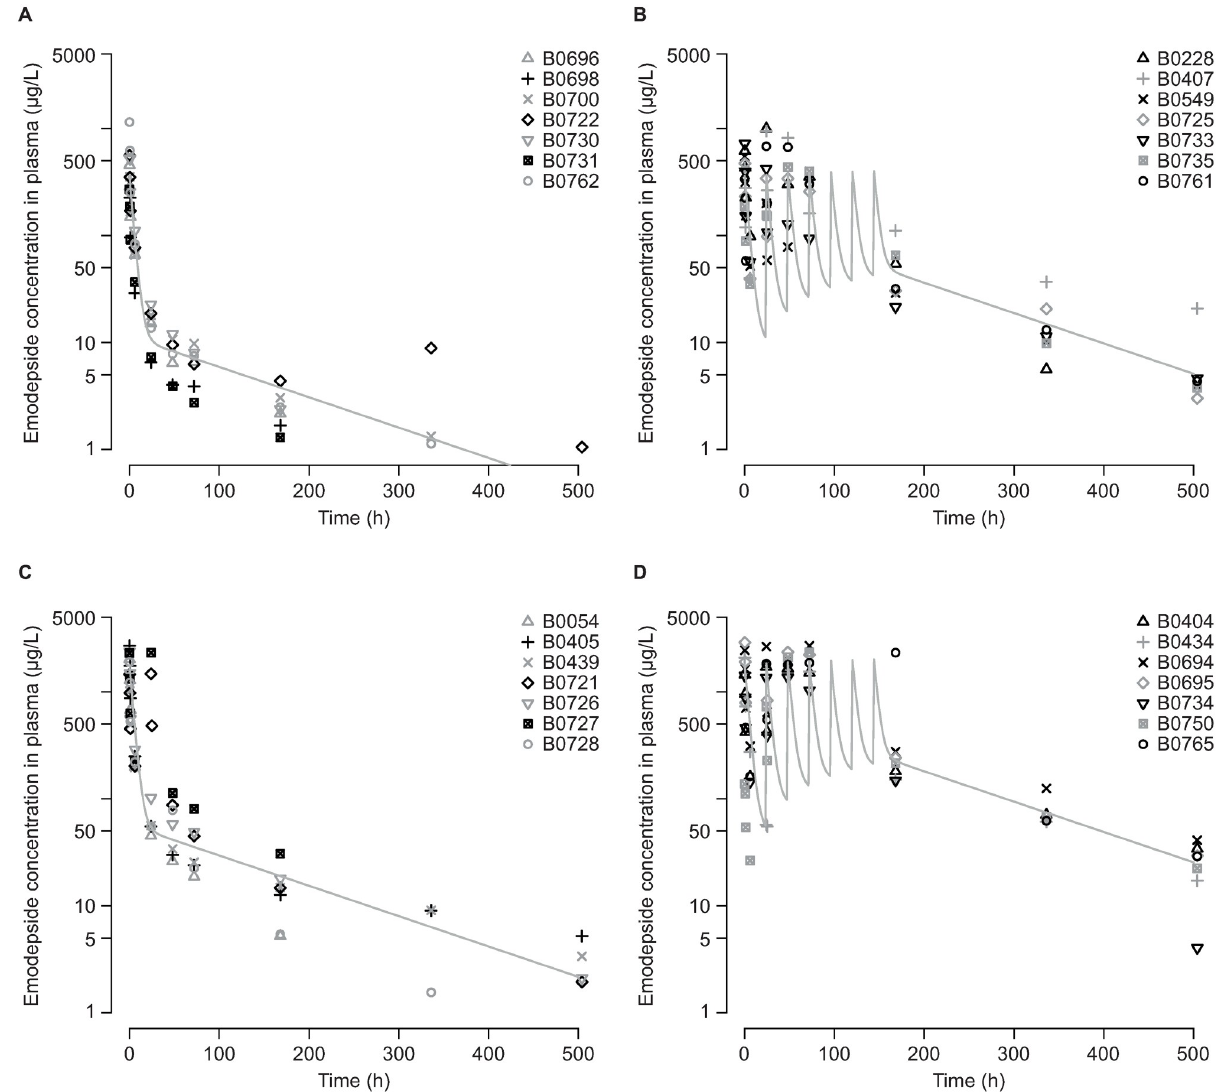
Fig 2. Observed plasma PK (concentration vs time curves) for four emodepside dose steps in zebu (Ngaounde´re´ Gudali) cattle ( B . t . indicus ). Dose groups were intravenous emodepside: A 0.15 mg/kg/day on day 0. B 0.15 mg/kg/day on days 0–6. C 0.75 mg/kg/day on day 0. D 0.75 mg/kg/day on days 0–6. Emodepside concentration in plasma was determined by tandem mass spectrometry using serial dilutions of single samples per animal ( n = 7 per dose group) at each timepoint. Symbols represent observations for individual animals; the lines represent the PK model of emodepside for that dosing regimen. Data are from a single study. No statistical comparisons were